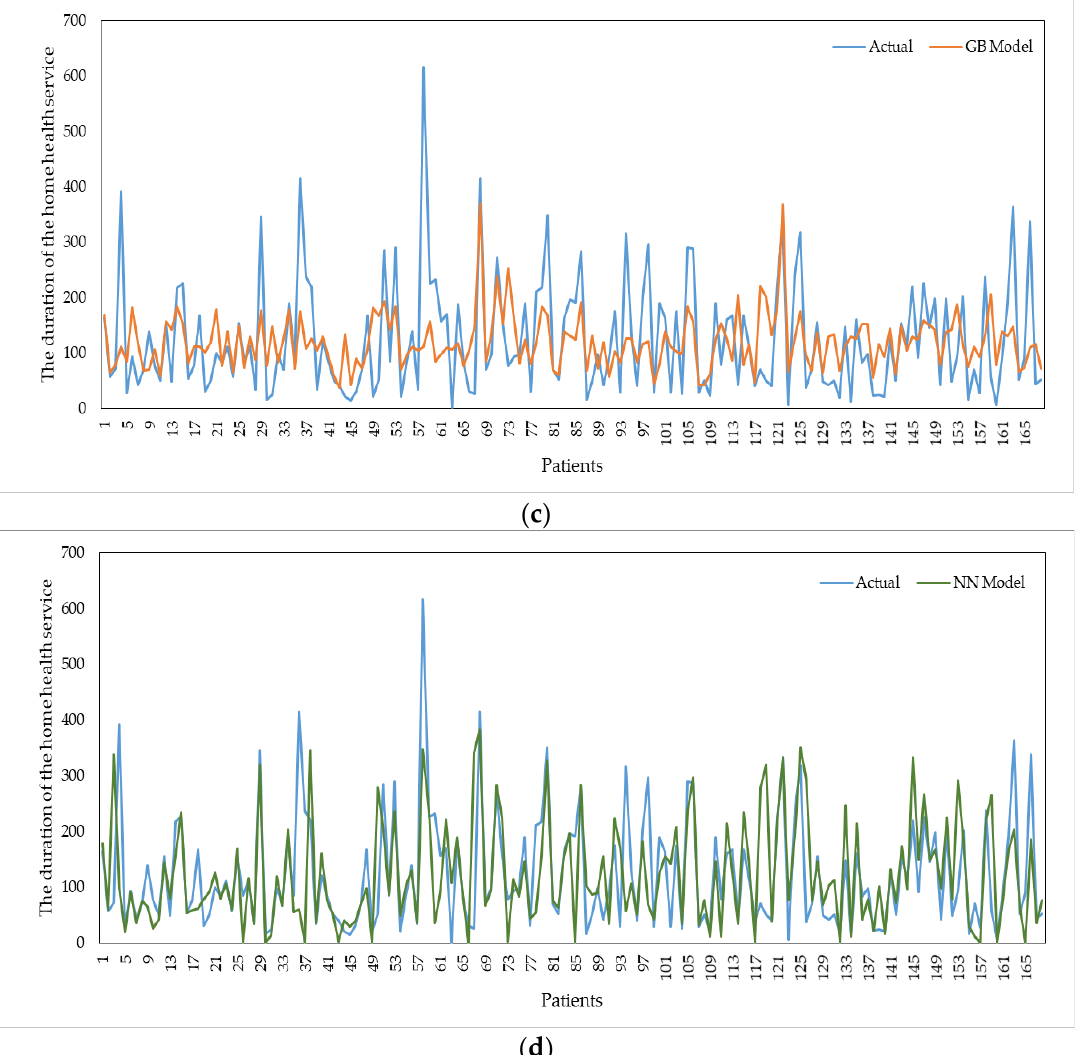
Figure 6. Comparison of forecast data of ML algorithms with real data ( a ) actual value vs. RF model, ( b ) actual value vs. AB model, ( c ) actual value vs. GB model, ( d ) actual value vs. NN model.